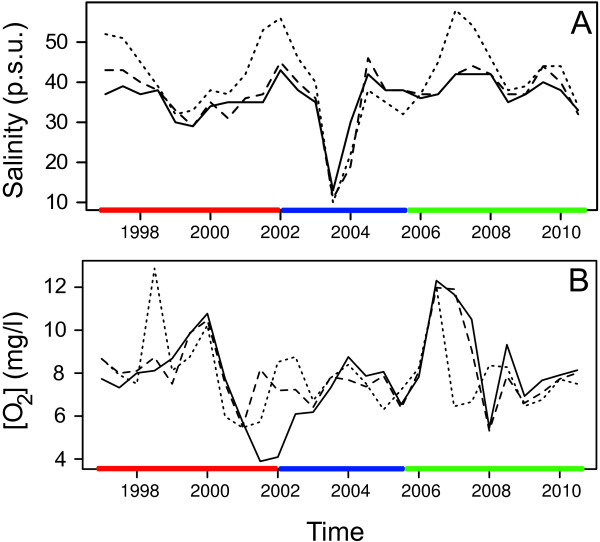
Temporal trend of salinity (A) and dissolved oxygen concentration (B). Solid line is for basin 1, dashed line for basin 2, and dotted line for basin 3. Red, blue, and green lines on the bottom of the graphs represent halt (1997-2002), eutrophication (2003-2005), and post-recovery (2006-2010) periods, respectively.